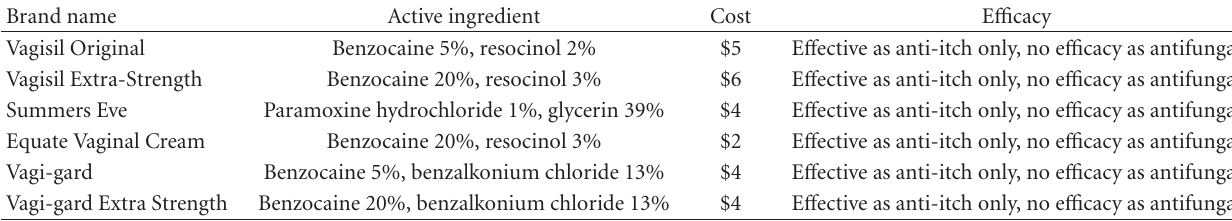
Table 4: Vaginal anti-itch creams.